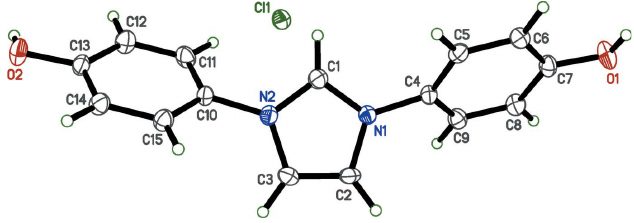
Figure 2 The molecular structure of IOH (cid:2) Cl, with displacement ellipsoids drawn at the 50% probability level.